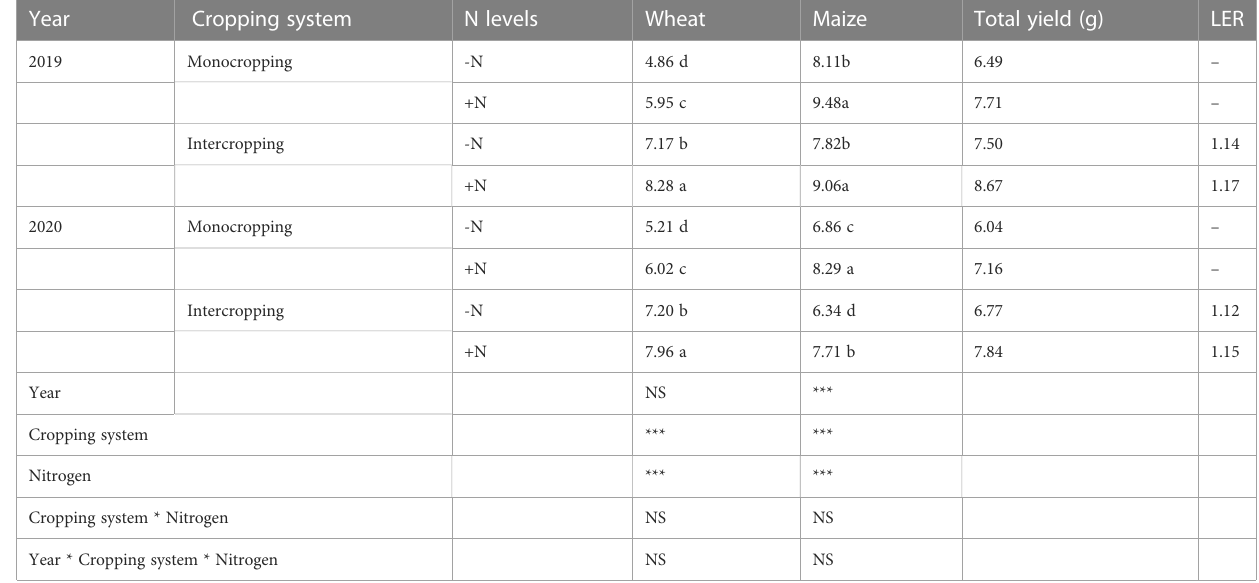
TABLE 2 Effect of wheat-maize intercropping system on wheat and maize yields (t ha -1 ) and land equivalent ratios (LER) of averaged yield with- (+N) and with-out nitrogen (-N) application.